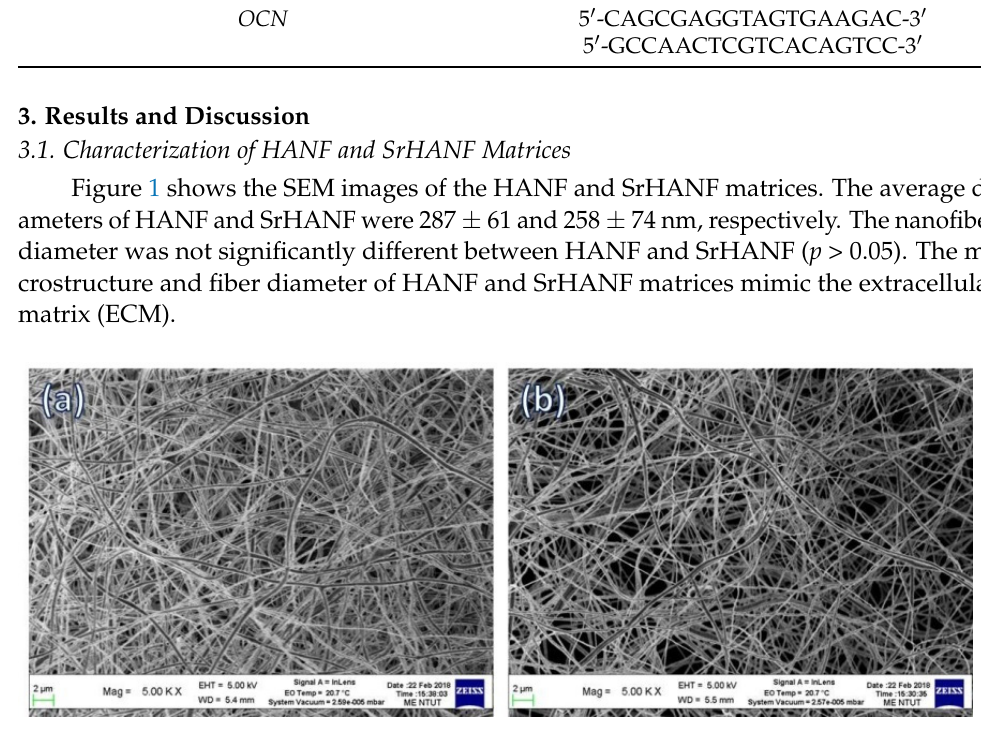
Figure 1. Microstructure of matrix. SEM images of ( a ) SrHANF and ( b ) HANF.